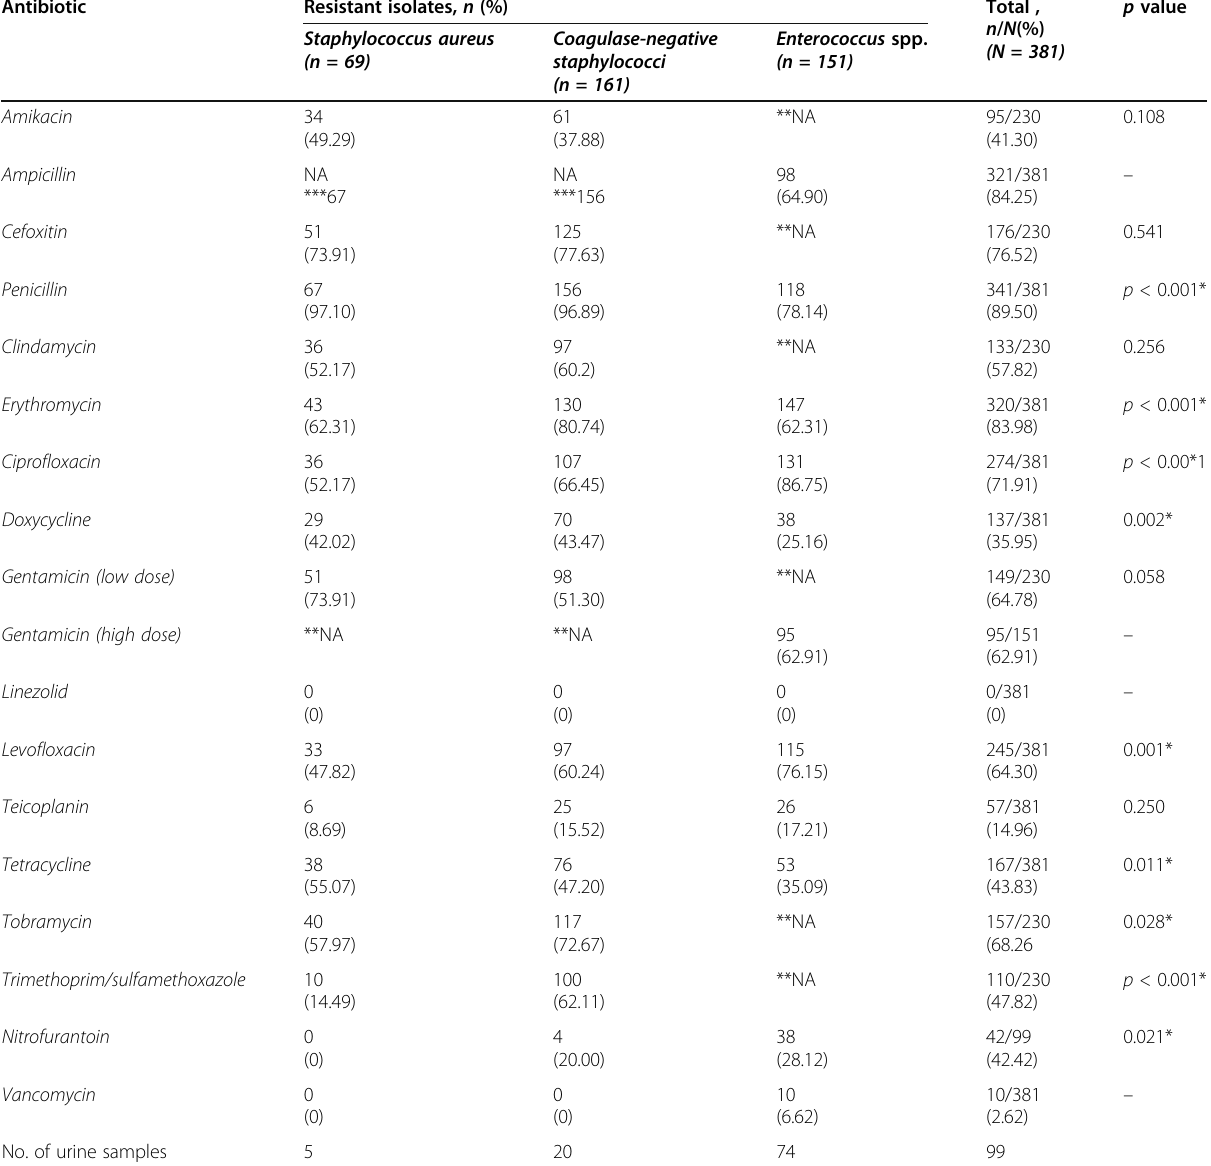
Table 4 Antibiotic resistance pattern of the prevalent Gram-positive pathogens isolated from patients admitted in ICU, Ain Shams University Hospitals, Egypt, March 2018-February 2019